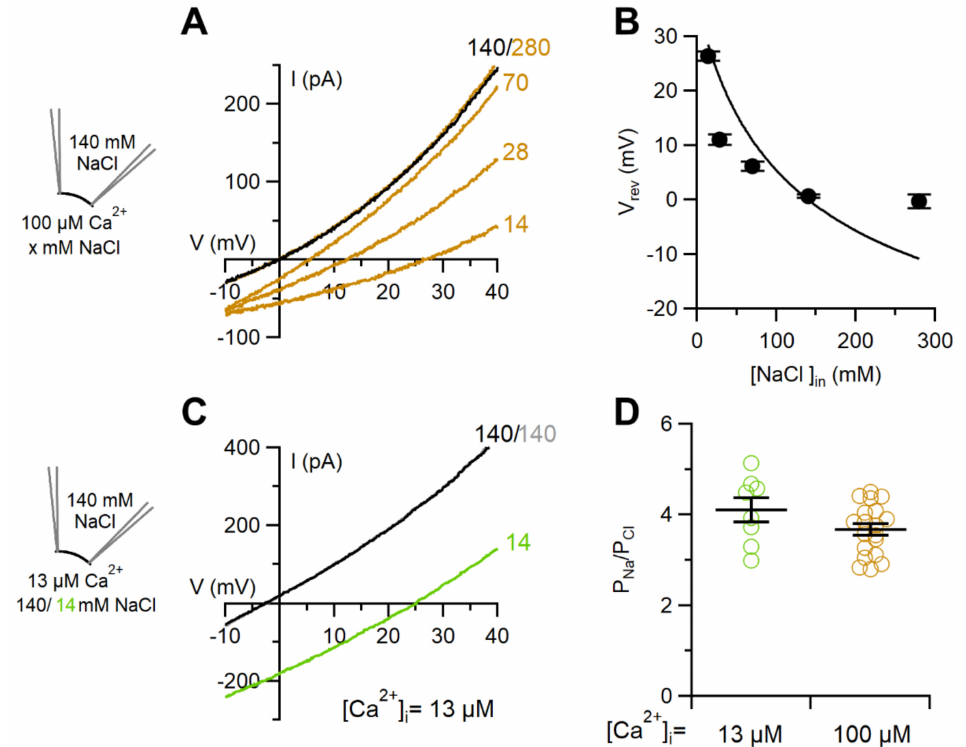
Figure 4. TMEM16F wt ion permeability ratio P Na /P Cl in excised inside-out patches depends on ionic strength but not on intracellular Ca 2+ concentration. ( A ) An inside-out patch expressing TMEM16F wt was exposed to the indicated cytoplasmatic NaCl concentrations (in mM) and the IV relations were determined by a voltage ramp from +100 to − 80 mV. Only the regions around the reversal potentials are shown. The current was activated by 100 µ M CaCl 2 . Leakage currents measured in 0 Ca 2+ were subtracted. ( B ) Average reversal potentials (V rev ) corrected for liquid junction potentials were plotted versus NaCl concentrations (n = 11–19). The continuous line was calculated according to the Goldman-Hodgkin-Katz equation with P Na /P Cl = 3.7. ( C ) An inside-out patch expressing TMEM16F was exposed to 140 or 14 mM cytoplasmatic NaCl and the IV relation was determined by a voltage ramp from +100 to − 80 mV. The current was activated by 13 µ M CaCl 2 . ( D ) Comparison of P Na /P Cl calculated with the Goldman-Hodgkin-Katz equation from reversal potentials measured with the indicated Ca 2+ concentration (n = 8–19, p = 0.19 unpaired t